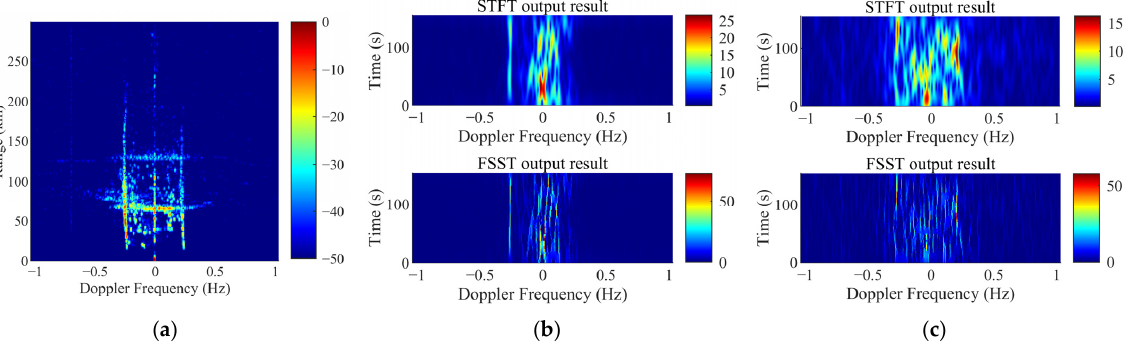
Remote Sens. 2022 , 14 , 3424 12 of 20